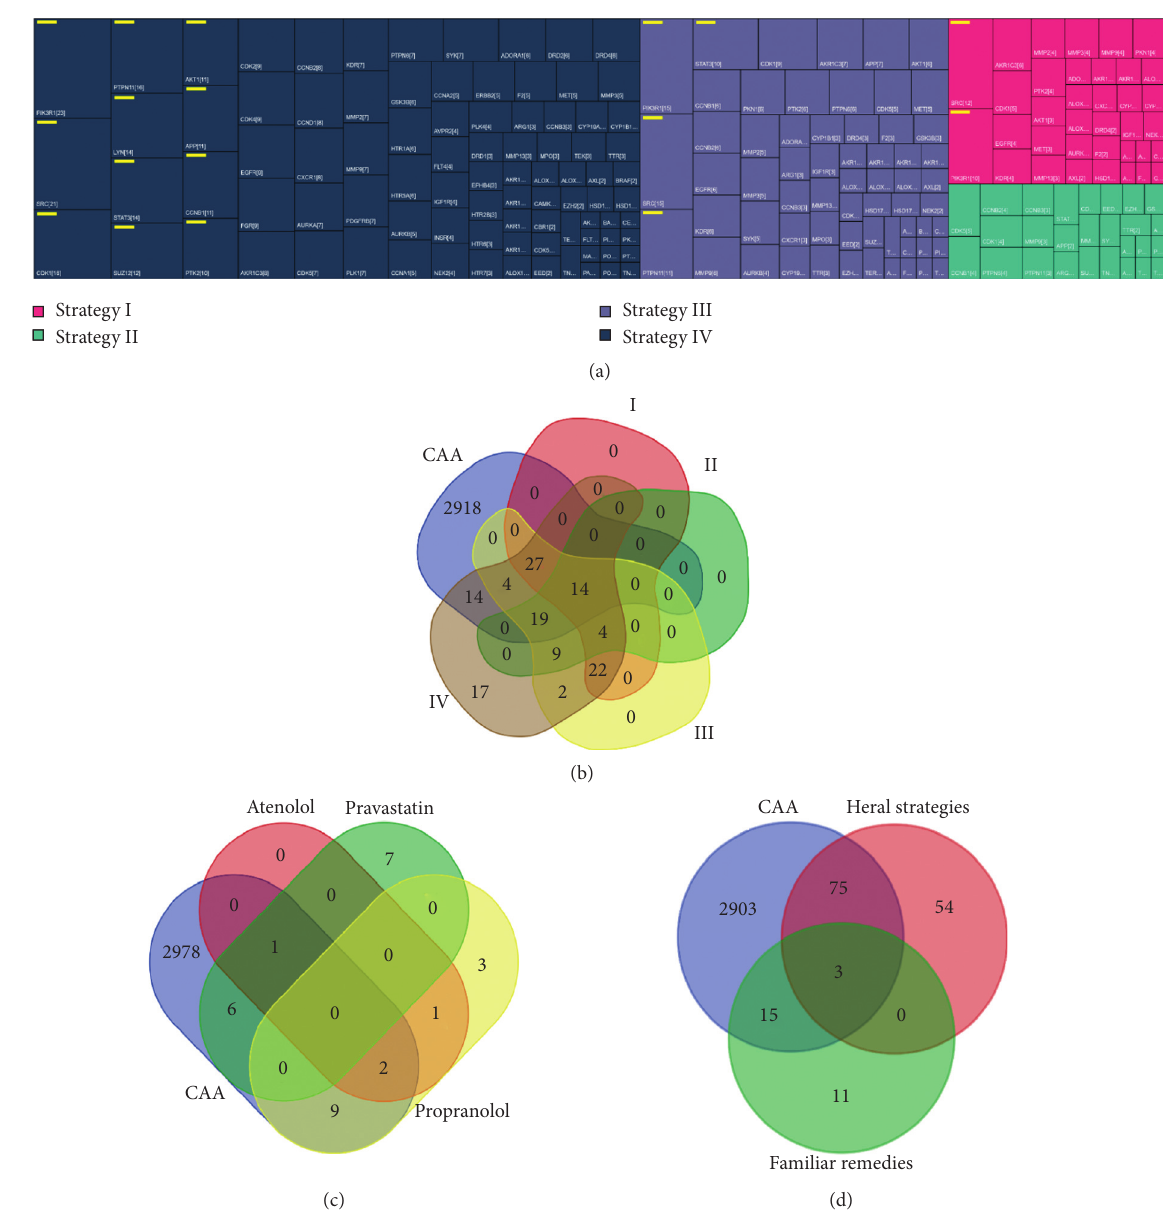
Figure 4: Protein network member and target amount. (a) Member information in interaction systems. Number of interaction partner is proportional to shape size and marked in square brackets. Yellow bar sign indicates that the number of interaction partner is greater than or equal to 10. (b–d) Number of common or unique targets comparing coronary artery atherosclerosis to herbal strategy (I, II, III, IV) or/and familiar remedy (atenolol, pravastatin, propranolol). I, II, III, IV, and CAA signify severally strategy I, strategy II, strategy III, strategy IV, and coronary artery